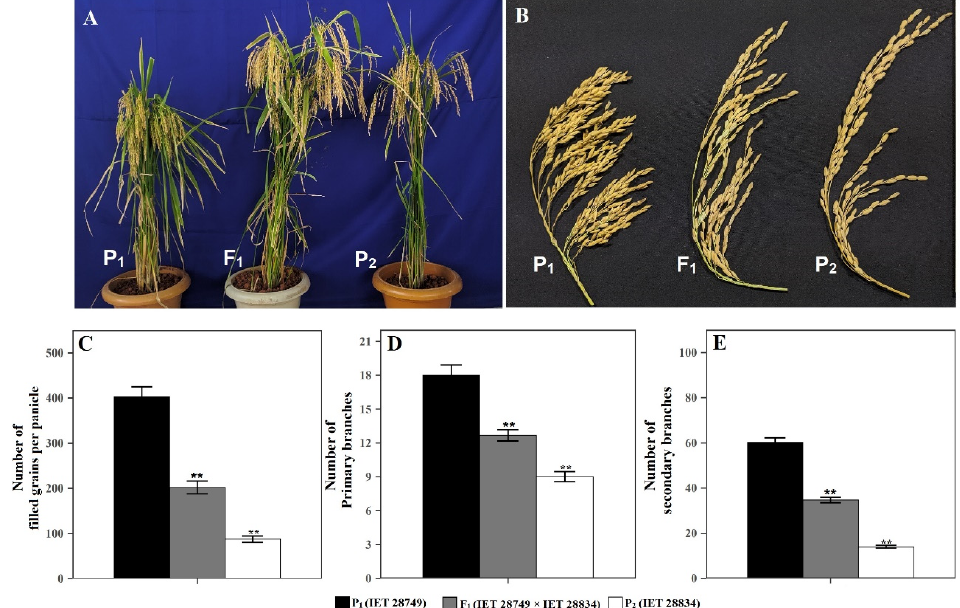
Figure 5. Phenotypic comparison of ( A ) plant, ( B ) panicle characteristic, ( C ) number of filled grains per panicle, ( D ) number of primary branches, and ( E ) number of secondary branches in High × Low cross (IET 28749 × IET 28834) (P 1 = IET 28749, P 2 = IET 28834, F 1 = IET 28749 × IET 28834). Error bar shows standard error ( n = 10); ** indicate significant difference from parent 1 (IET 28749) as compared by the Student’s t -test.